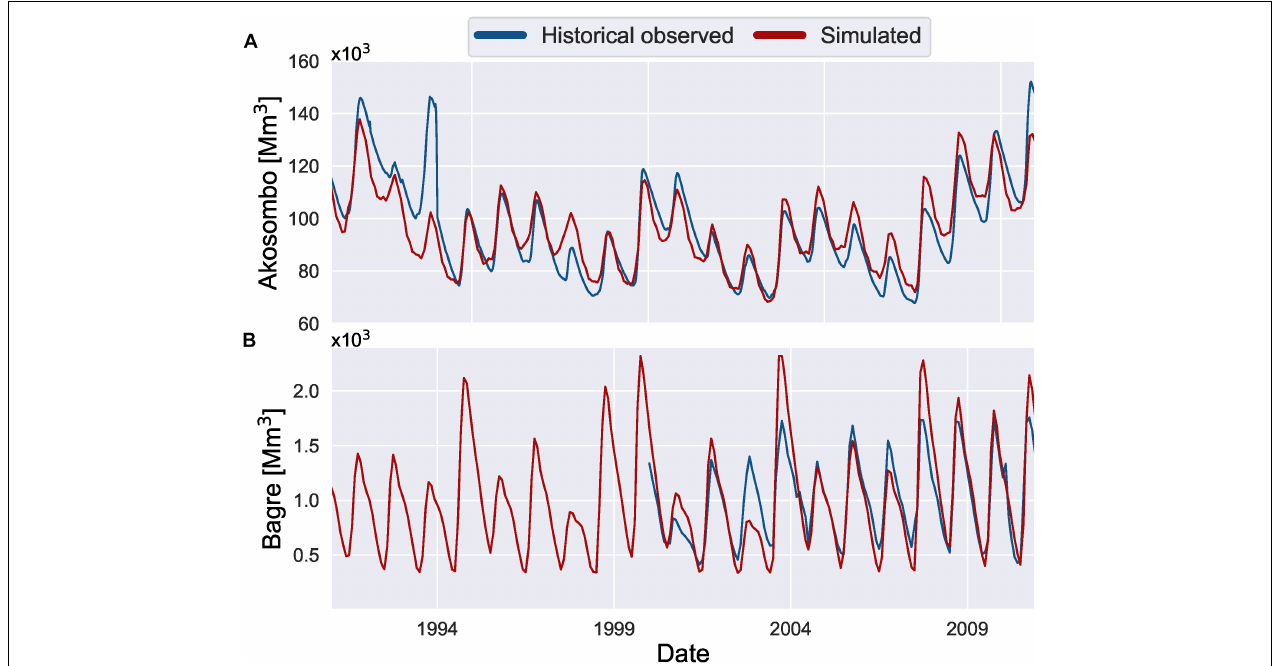
FIGURE 4 | Comparison of observed and simulated reservoir volumes used for policy identification. Panel (A) shows the observed and simulated volume for the Akosombo reservoir, and panel (B) shows the observed and simulated volume for the Bagre